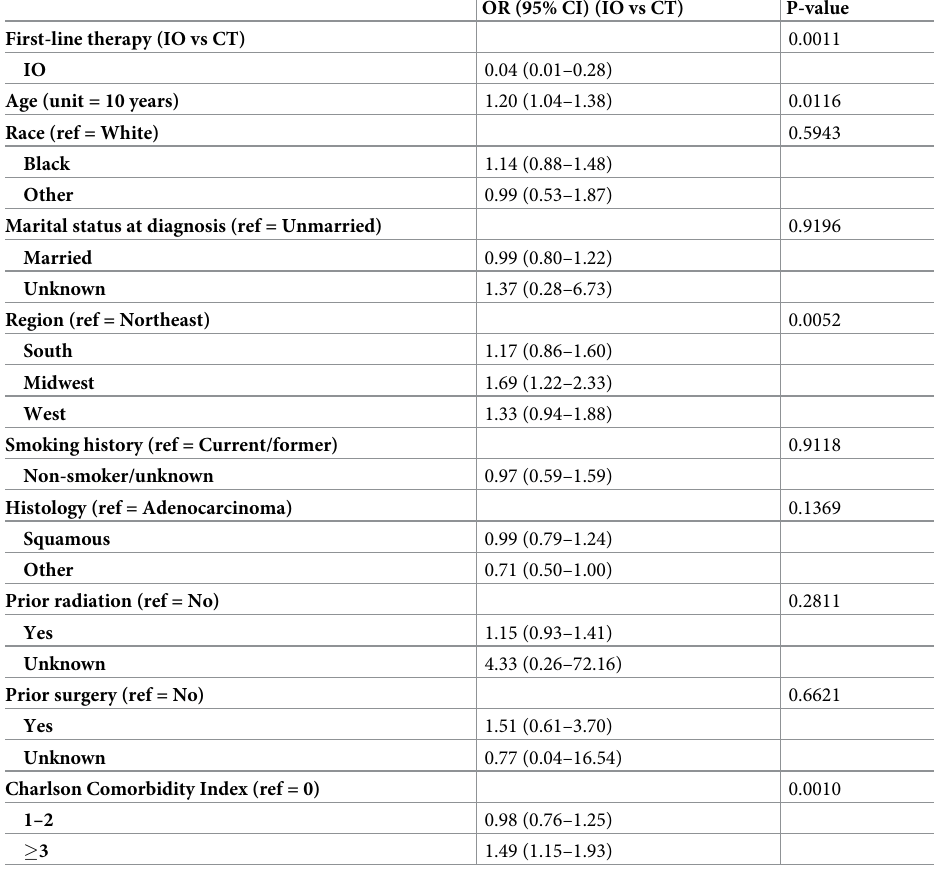
Table 2. Multivariable logistic regression to assess association between patient characteristics and receipt of 2L IO vs